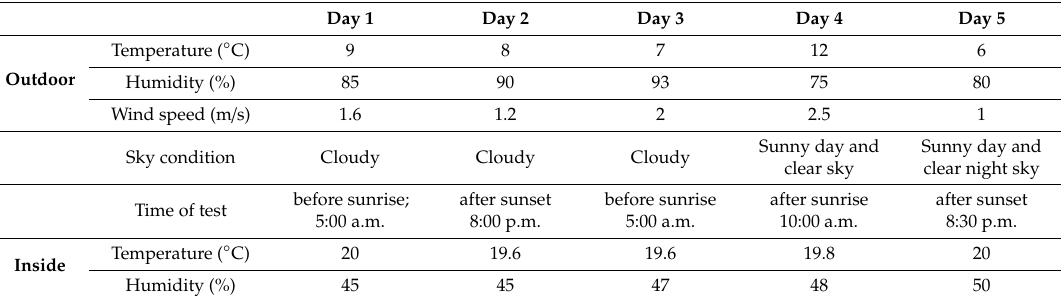
Table 4. Climatic conditions at the beginning of each